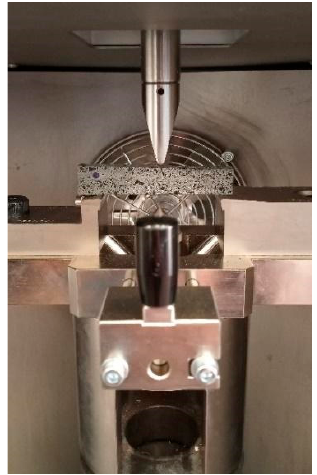
Figure 7. Experimental set-up for Charpy impact test.